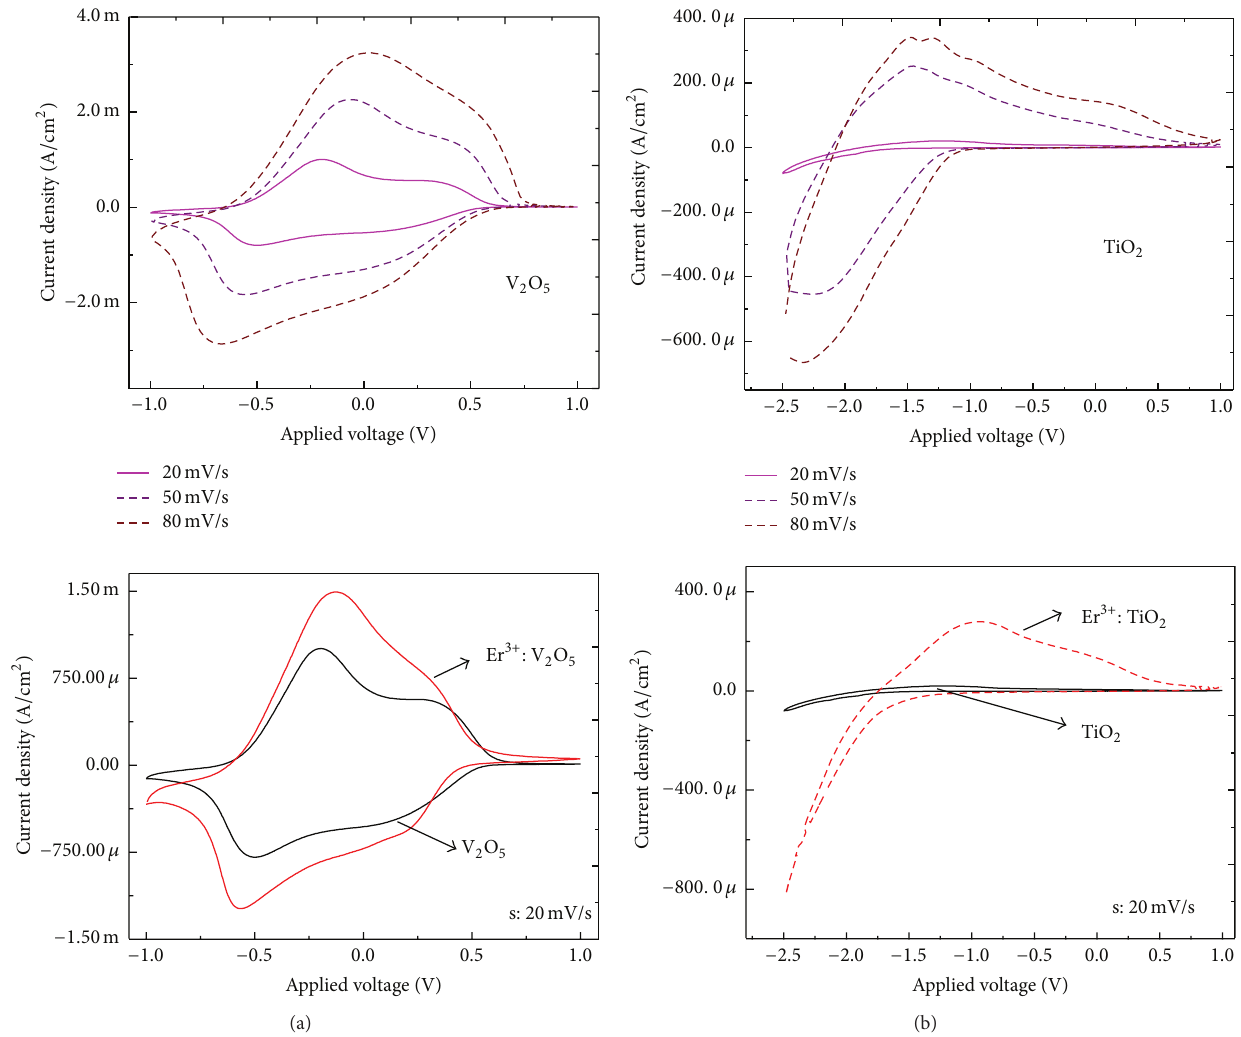
Figure 7: Cyclic voltammograms of the (a) V 2 O 5, (b) TiO 2 films at different scan